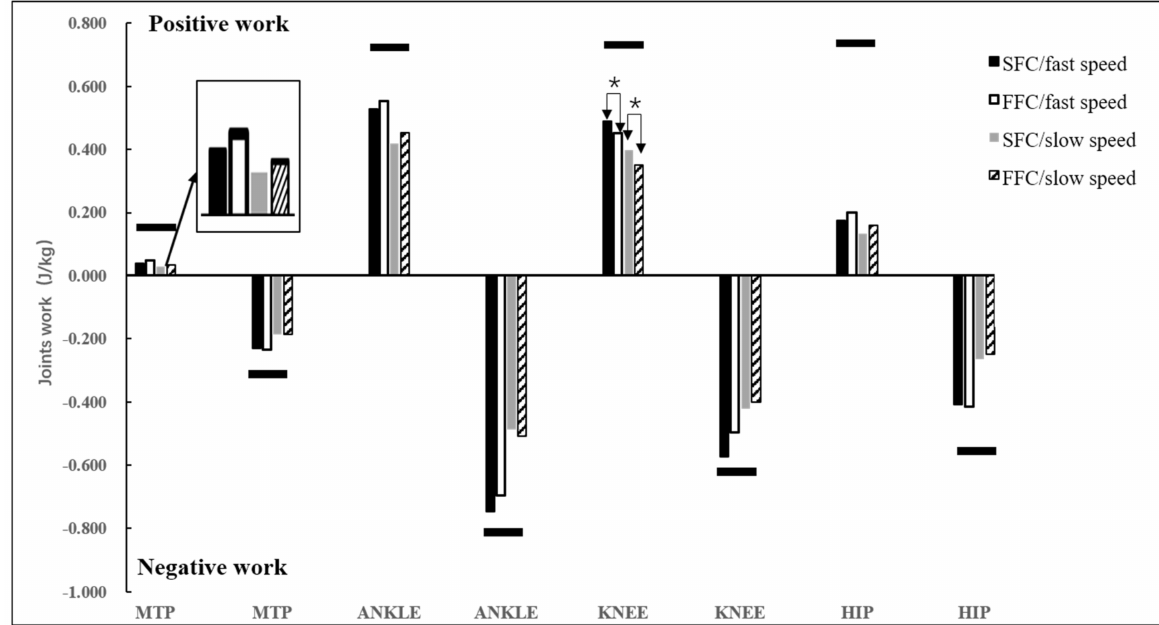
Figure 7. Joints work and showed significant main effects of the interaction; the black horizontal bars showed significant main effects of speed; and the * showed significant main effects of the construction of the carbon fiber